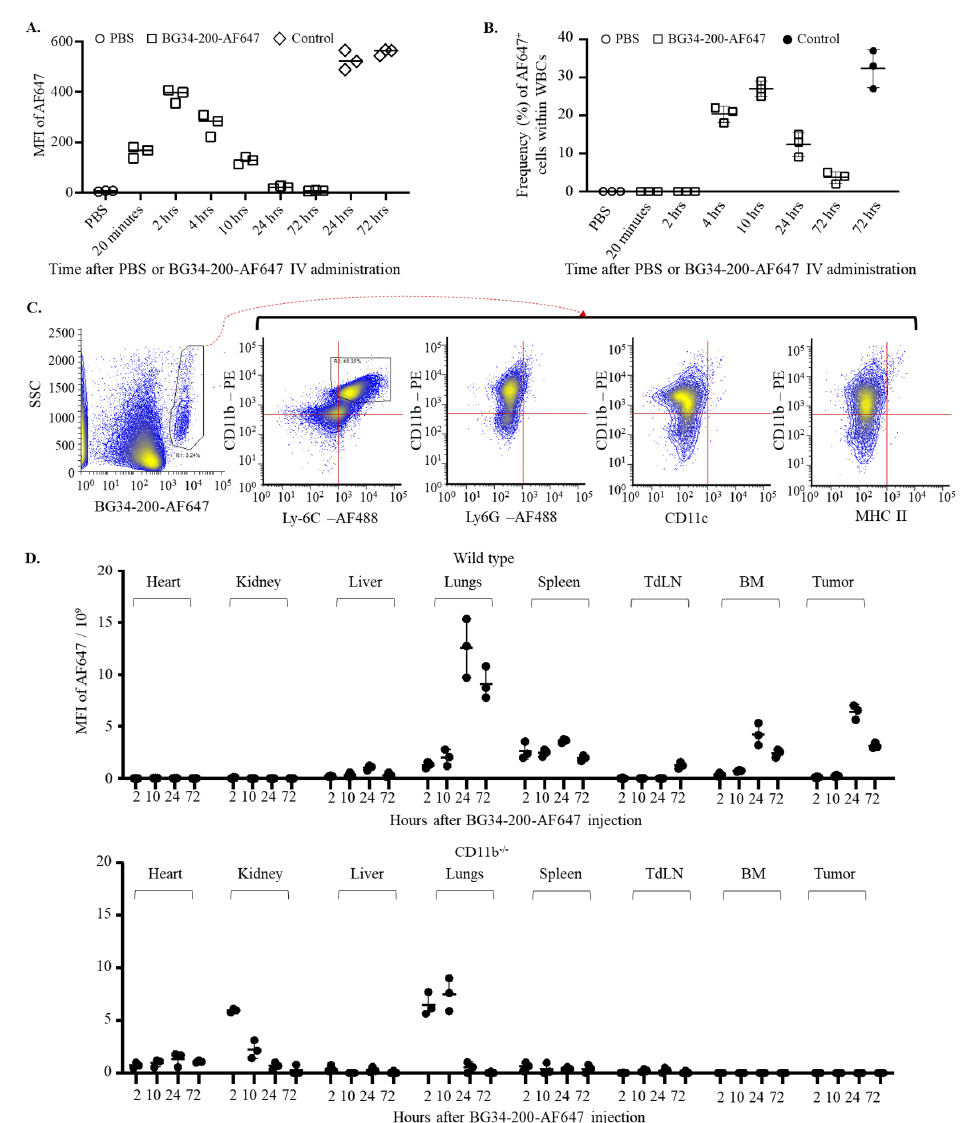
Figure 2. Direct entry of BG34-200-AF647 into circulating CD11b + cells facilitates plasma clearance of the compound and mediates absorption in peripheral organs and tumor. ( A ). Fluorescence signal in plasma samples over 72 h after IV administration of PBS or BG34-200AF647 in B16F10 mice. Tumor-free mouse plasma samples spiked with BG34-200-AF647 for 24 and 72 h served as positive controls. ( B ). Frequency of AF647 + WBCs over 72 h after IV administration of BG34-200AF647 or PBS. Tumor-bearing mouse WBCs spiked with BG34-200-AF647 for 72 h served as positive control. ( C ). FACS analysis (phenotyping) of the BG34-200-AF647 + WBCs population harvested at 10 hrs after BG34-200-AF647 + IV administration using PE-tagged CD11b and AF488-tagged Ly6C, Ly6G, CD11c, or MHC II. ( D ). MFI of BG34-200-Af647 signals in the heart, kidneys, liver, lungs, spleen, tumor-draining lymph nodes (TdLNs), bone marrow (BM), and tumor at 2, 10, 24, and 72 h after IV administration of BG34-200-AF647 compound in the wild-type (WT) mice (top panel) and CD11c − / − mice (bottom panel) as determined by colorimetric analysis. For ( A , B , D ), n = 9; each data point represents a sample pooled from three mice, and each data point was determined in triplicate. Data are graphed as mean ± SD.